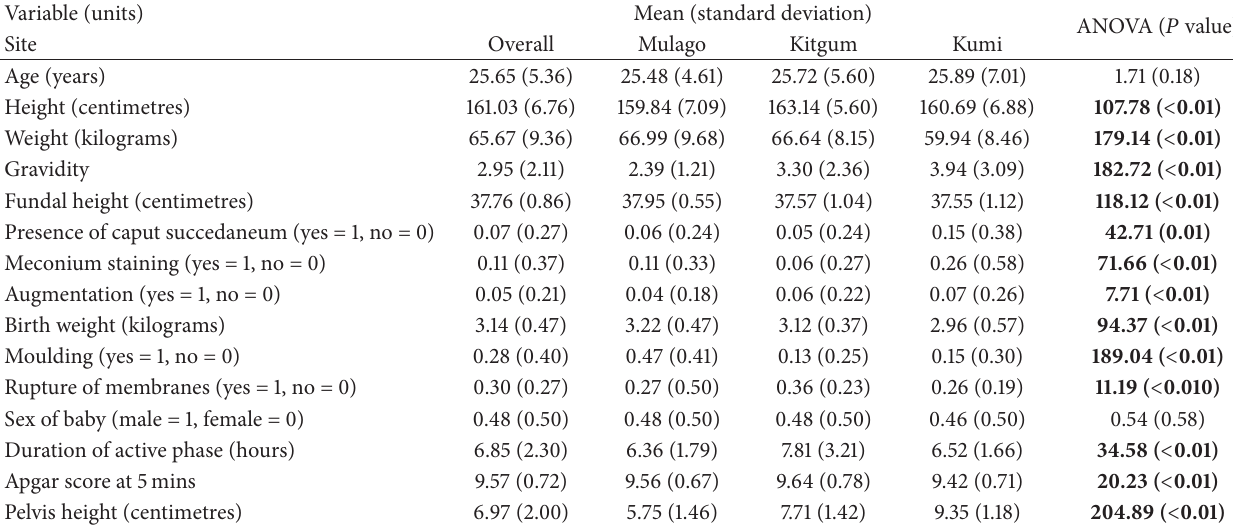
Table 2: Showing the comparison of means for the different variables by study